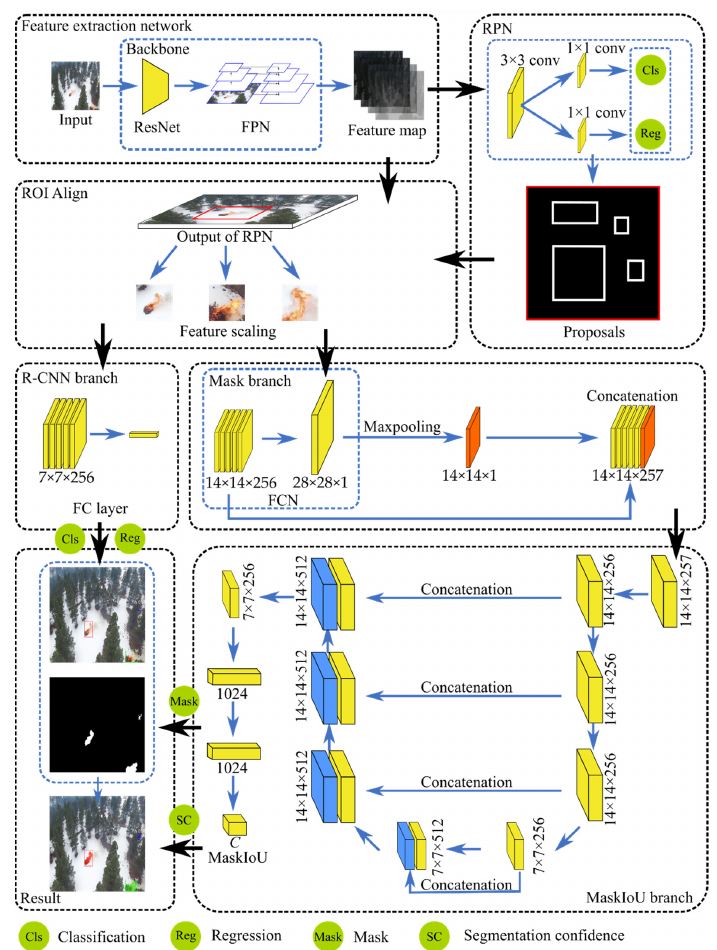
Figure 5. Our proposed MaskSU R-CNN model for fire segmentation.